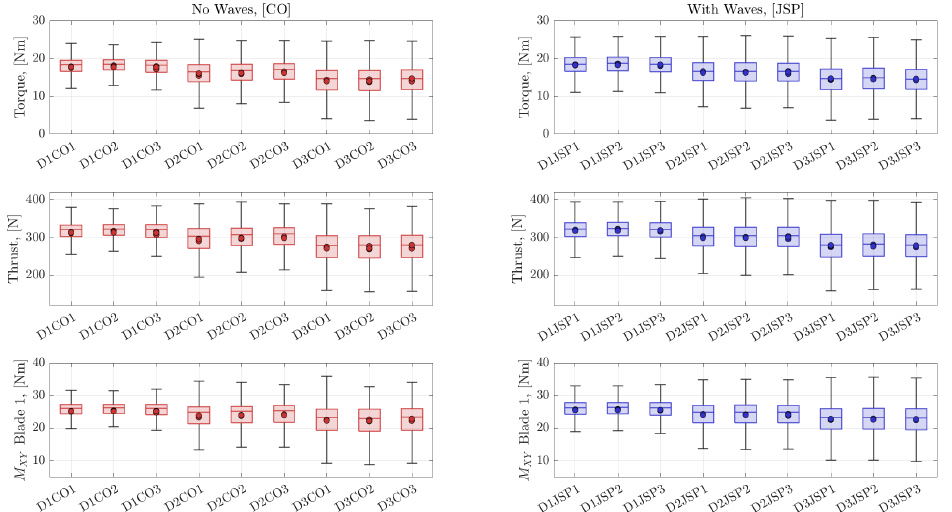
Figure 8. Box plots of turbine loading for every case undertaken, including repeats. Upper charts show torque, central charts thrust and lower charts BRBM. Left charts show the CO cases and right charts show JSP